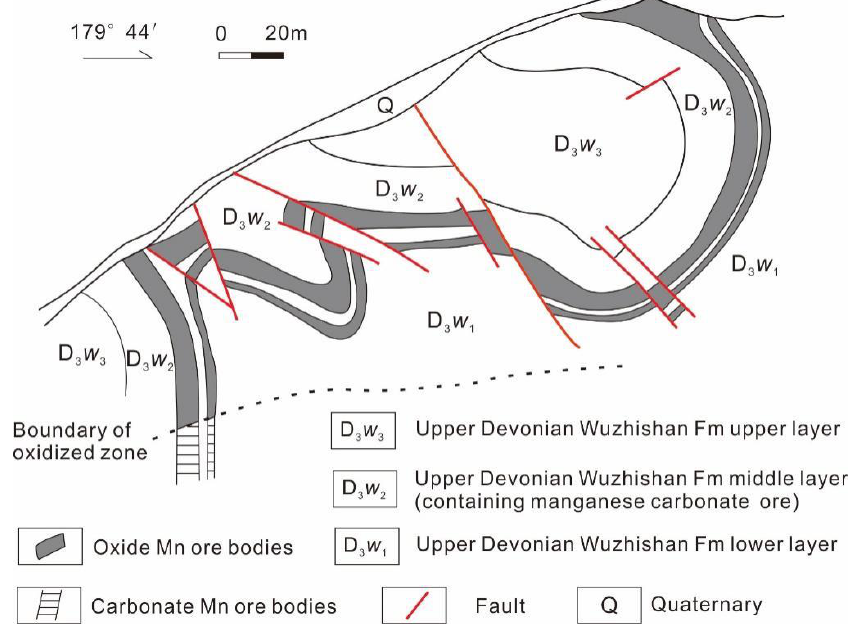
Figure 2. Cross section showing the geometry of supergene Mn oxide bodies (modified after [18]).